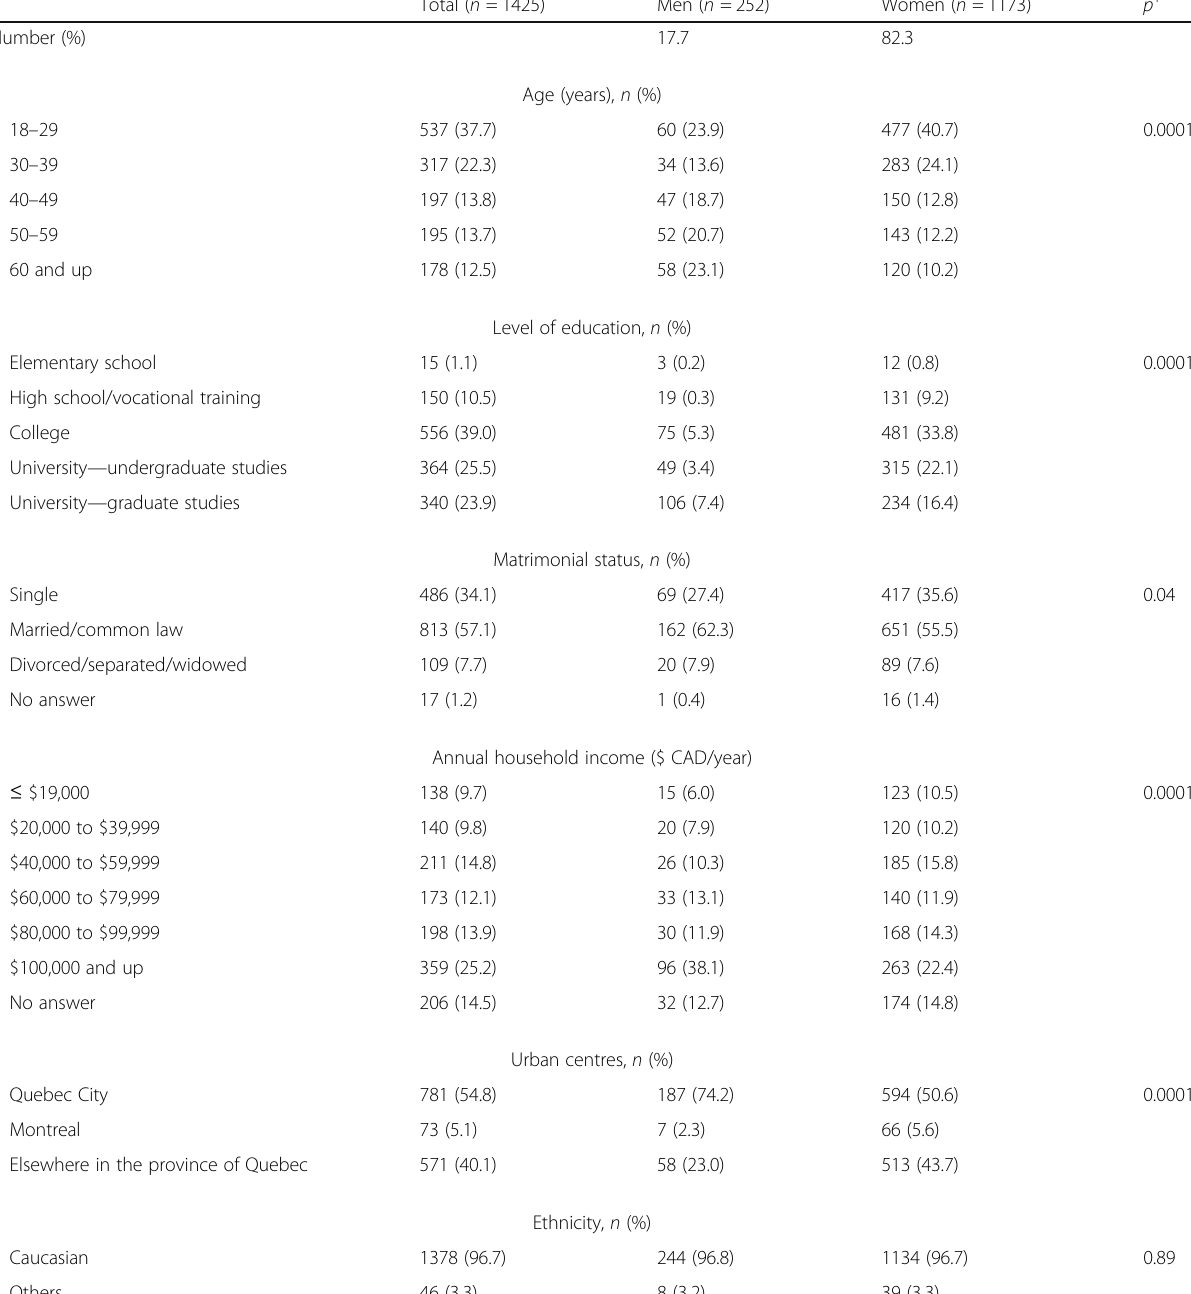
Table 1 Characteristics of individuals who participated in the Quebec-wide e-consultation on